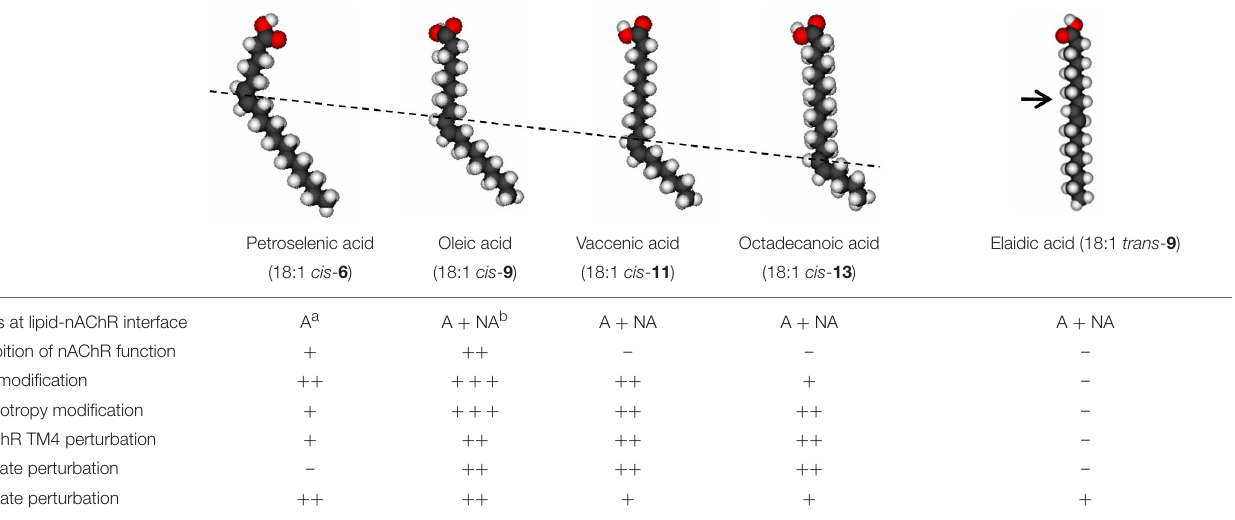
TABLE 1 | Summary of effects produced by different FFAs on the nAChR (Perillo et al.,